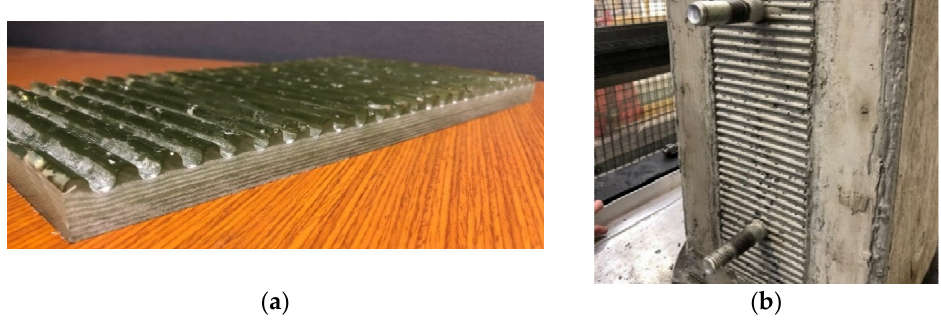
Figure 4. Elements of Ridged Shear-Friction Connection: ( a ) FRP Plate Infused with Ridges Using Caul Plate; ( b ) Concrete Surface Cast Against Ridged FRP Plate.